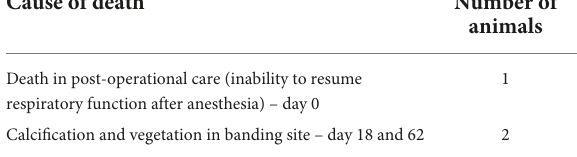
FIGURE3 Study flowchart.